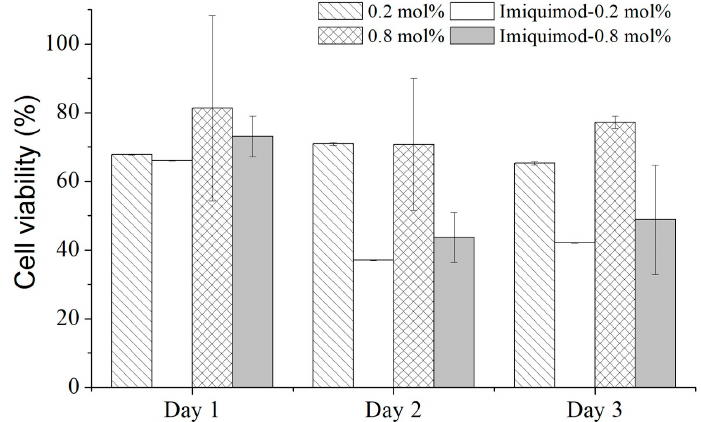
Figure 11. The cell viability was measured from keloid fibroblasts cultured on the polystyrene dish, pure-poly(MEO 2 MA) hydrogel, and imiquimod-poly(MEO 2 MA) hydrogel, crosslinked with 0.2 mol % and 0.8 mol % of DEGDMA by using Cell Counting Kit-8 (CCK-8) assay and enzyme-linked immunosorbent assay (ELISA).